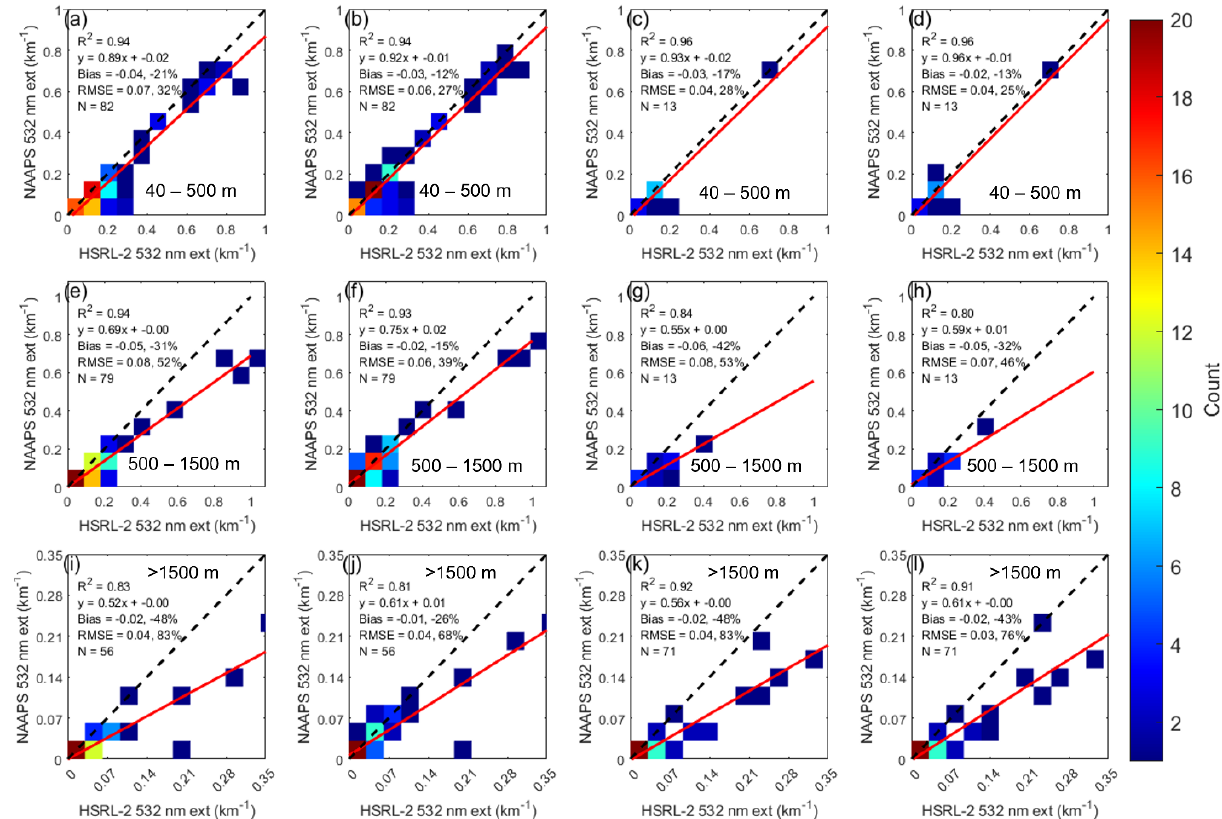
Figure 4. Comparison of simulated (NAAPS-RA) and retrieved (HSRL-2) 532nm extinction coefficients when NAAPS-RA underestimated both extinction and RH. (a, b) Comparison when NAAPS-RA simulations were performed using either (a) NAAPS-RA RHs or (b) dropsonde RHs for altitudes between 40–500m and when final dropsonde RHs are > 80%. (c, d) Same as ( a, b, respectively) except when final dropsonde RHs were < 80%. (e, f) Same as ( a, b, respectively) except for altitudes between 500–500m. (g, h) Same as ( e, f, respectively) except when final dropsonde RHs are < 80%. (i, j) Same as ( a, b, respectively) except for altitudes > 1500m. (k, l) Same as (i, j) except when final dropsonde RHs are < 80%. Linear fits are indicated with red lines, 1 : 1 lines are shown as dotted lines, and the color bar shows the number of points falling in each bin. Where bias and RMSE are reported, the first and second numbers are the absolute and relative values,